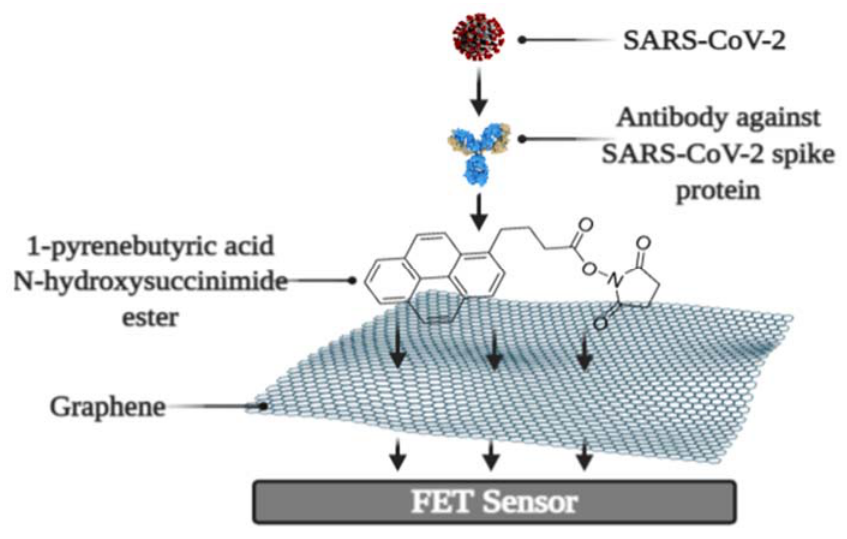
Figure 5. Schematic representation of FET immunosensor. Figure from [22]. Quartz Crystal Microbalance Based Biosensors